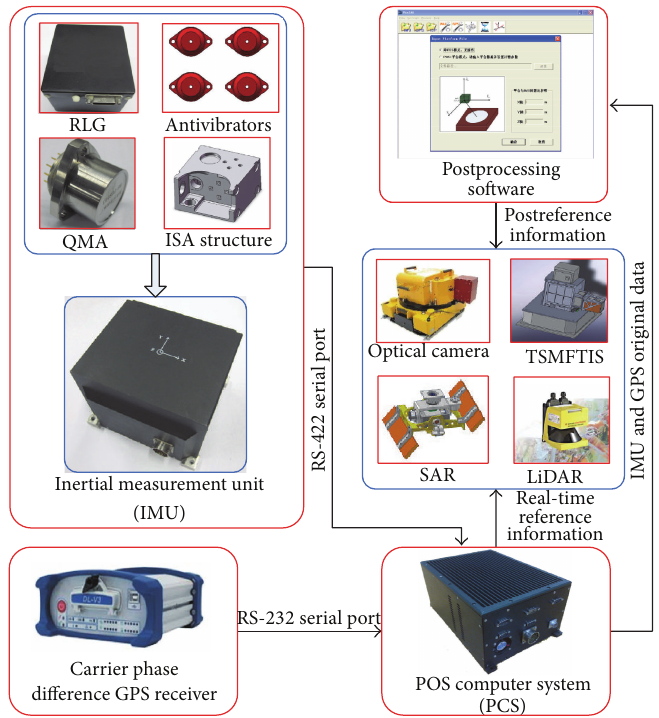
Figure 1: The components and operation principle of